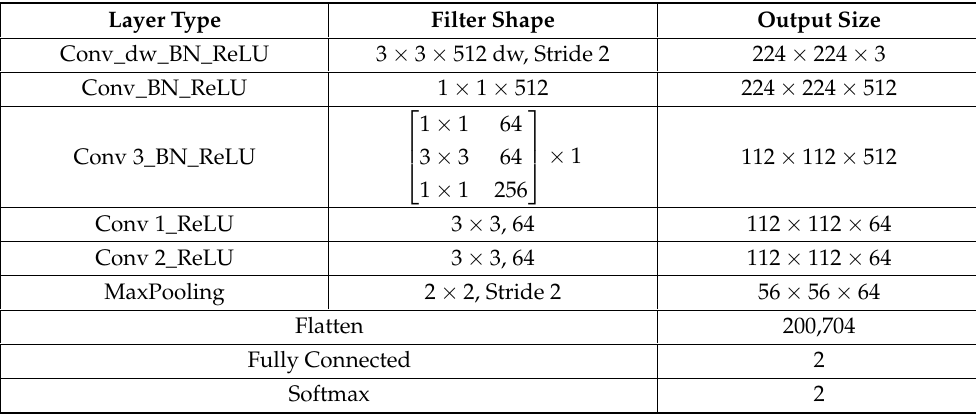
Table 7. Model architecture selected in sixth training iteration by designed AutoML model.